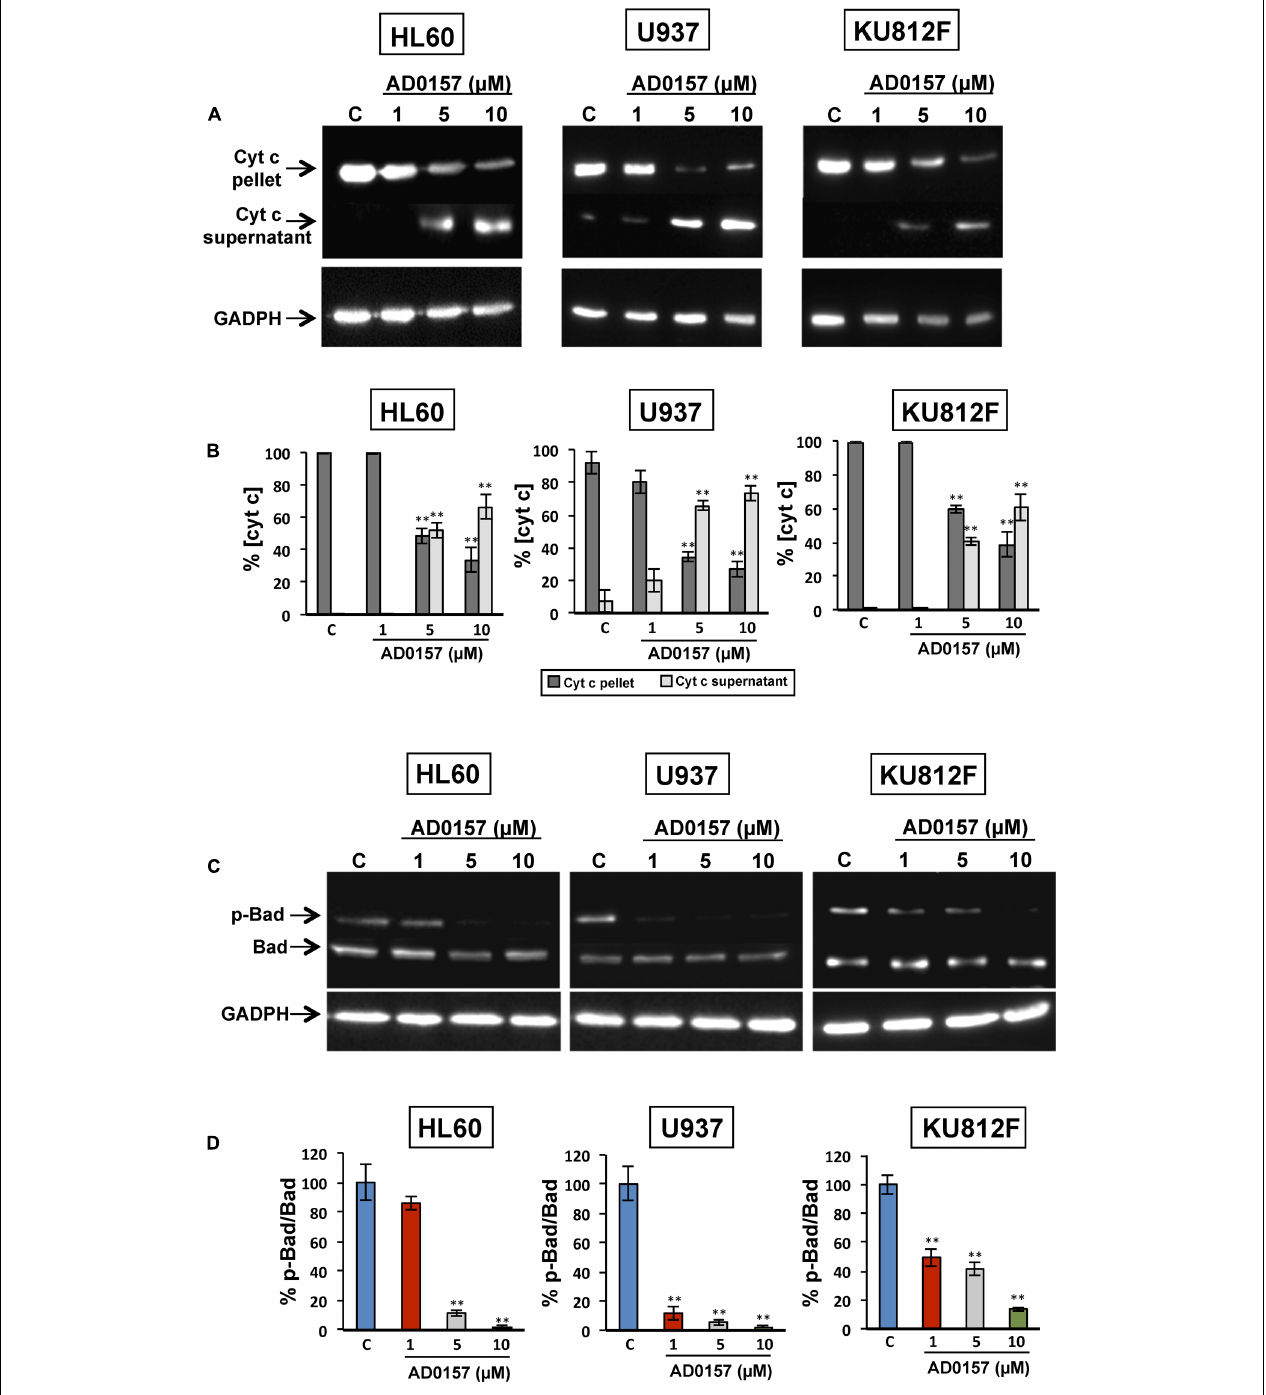
FIGURE 7 | AD0157 induces the release of cytochrome c into the cytosol and suppresses Bad phosphorylation. (A) Detection of cytochrome c in the cytosolic (supernatant) and mitochondrial (pellet) fractions of AD0157-treated and non-treated leukemia cells. HL60, U937 and KU812F cells incubated with AD0157 were suspended in MSH buffer containing EGTA, succinate and MgCl 2 , permeabilized with digitonin and the cytosolic and mitochondrial fractions were separated and subjected to Western blots. (B) Percentage of cytochrome c in the pellet (mitochondria) and supernatant (cytosol) after treatment with AD0157, expressed as means ± SD of three independent assays. ∗∗ p < 0.001 versus control. (C) Bad phosphorylation status in treated and untreated HL60, U937 and KU812 cells. Representative blots of p-Bad and total Bad in the studied leukemia cell lines. (D) Percentage of p-Bad/Bad ratios expressed as means ± SD of three independent assays. ∗∗ p < 0.001 versus